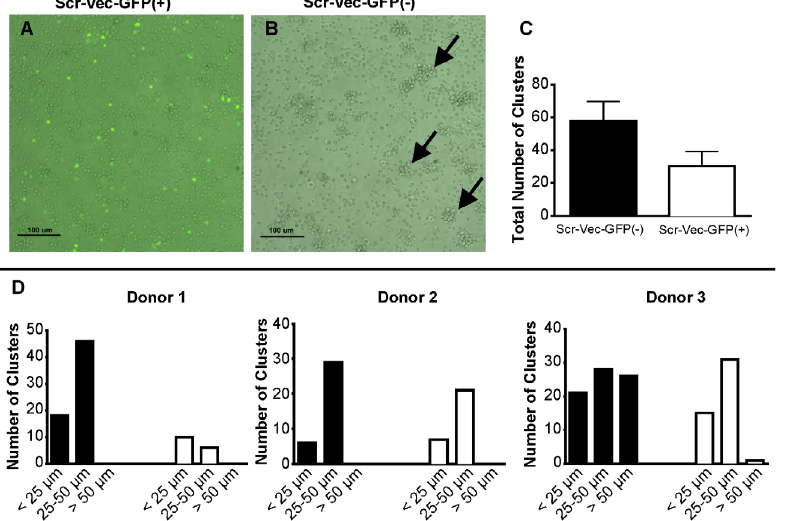
Figure 1. TurboGFP impairs T cell clustering after CD3/CD28 activation. T cells were transfected with either the Scr-Vec-GFP( + ) or the Scr- Vec-GFP( 2 ) vectors, then activated by plate-bound anti-CD3 and soluble CD28 for 20 hours. A) GFP-expressing T cells exibit impaired clustering after CD3/CD28 activation. B) Normal cluster formation of CD3/CD28-activated T cells in sample transfected with the Scr-Vec-GFP( 2 ) are indicated by black arrows. A representation of 3 independent experiments is shown. C & D) Activated cell clusters were quantified within one representative field of view at 100x for the Scr-Vec-GFP( 2 ) vector and the Scr-Vec-GFP( + ) vector transfections to obtain the total number of clusters (C), or the numbers of clusters by size range ( , 25 m m, 25–50 m m, and . 50 m m) (D) where the black bars indicate the Scr-Vec-GFP( 2 ) transfections and the white bars indicate the Scr-Vec-GFP( + ) transfections. Mean and SEM are shown.